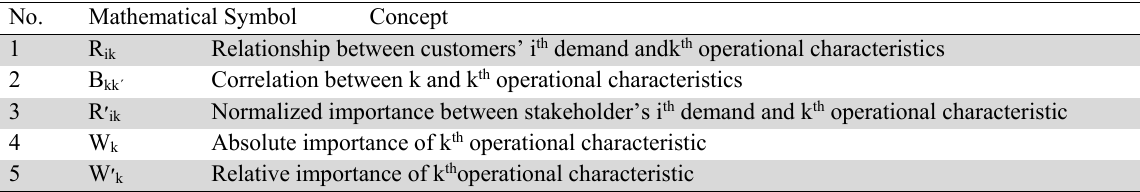
Concept of mathematical